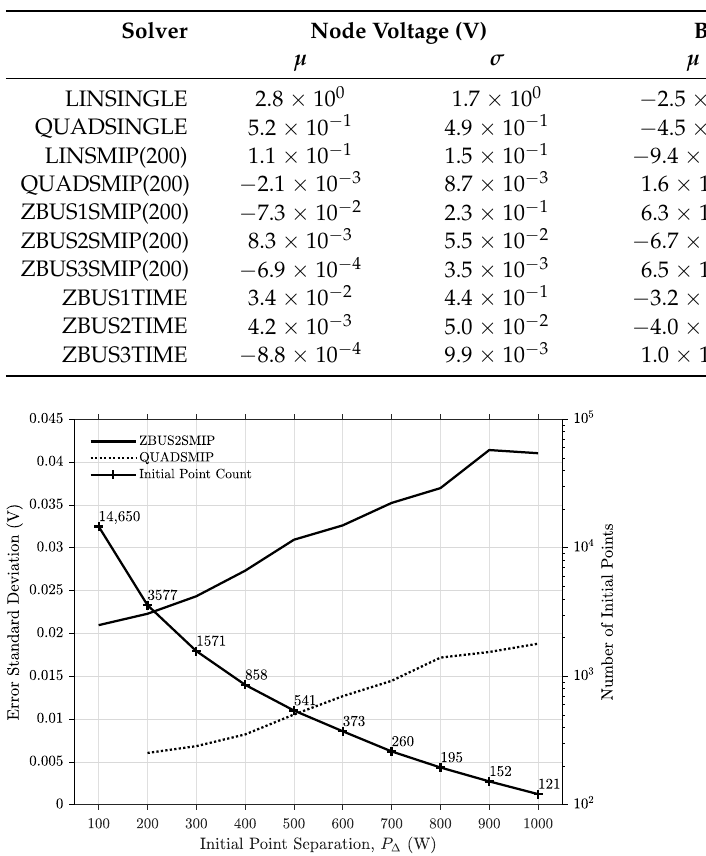
Table 6. Solver accuracy as measured by the mean bias ( µ ) and standard deviation ( σ ) of the error for the node voltage and branch current with the largest absolute bias.